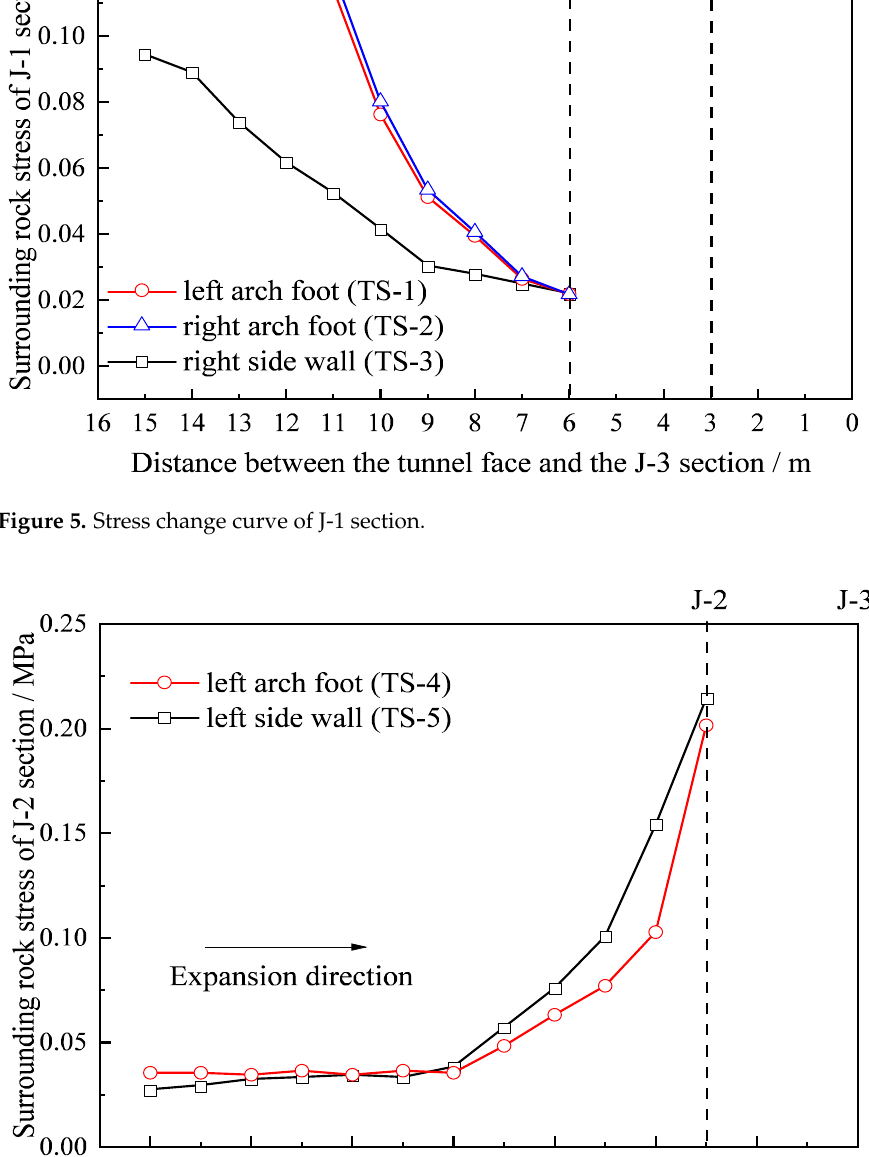
Figure 6. Stress change curve of J-2 section.